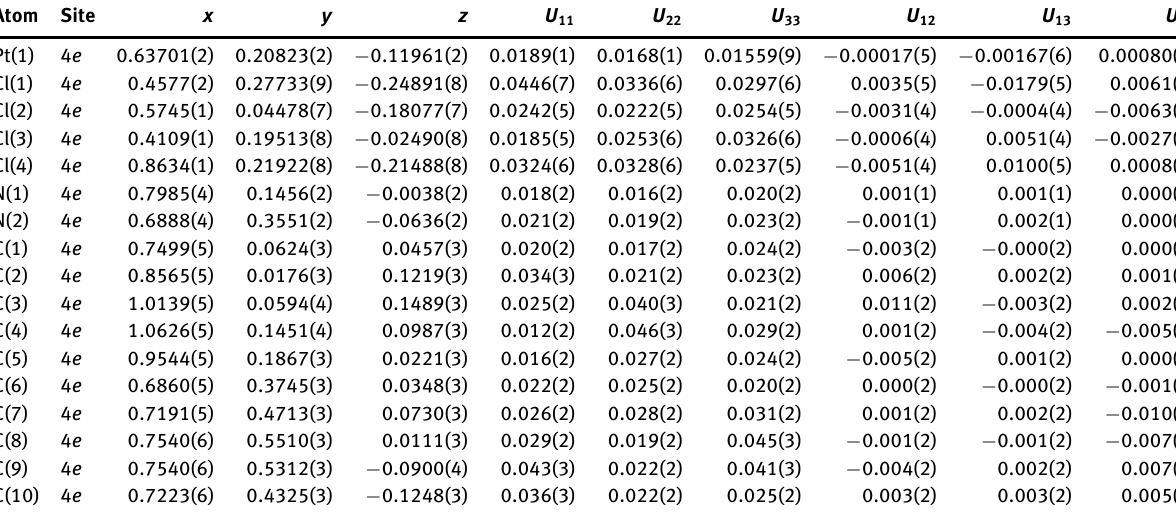
Table 3: Atomic coordinates and displacement parameters (Å 2